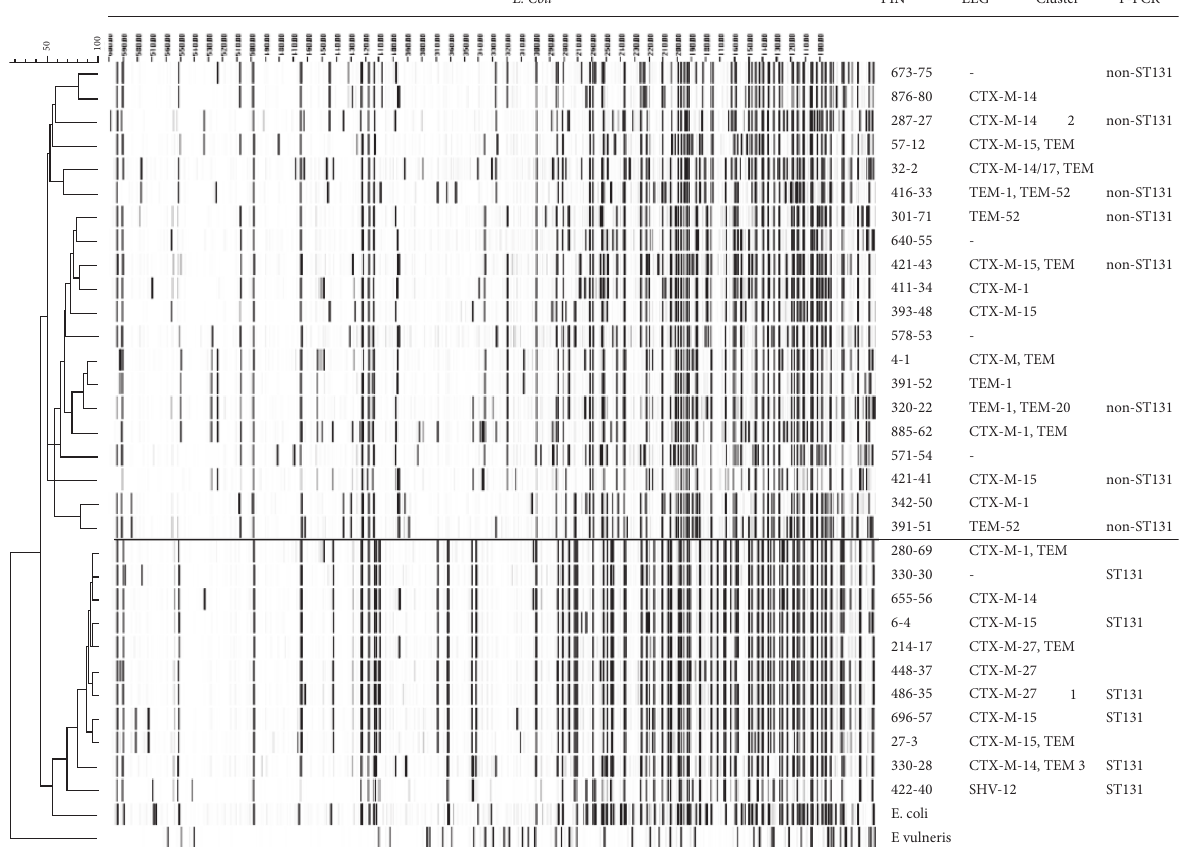
Figure 2: AFLP-results of all E. coli isolates with one representative isolate per cluster. Abbreviations: PIN � patient identification number; EEG � ESBL encoding gene; and P-PCR � phylogroup defining polymerase chain reaction. https://doi.org/10.1371/journal.pone.0222200.